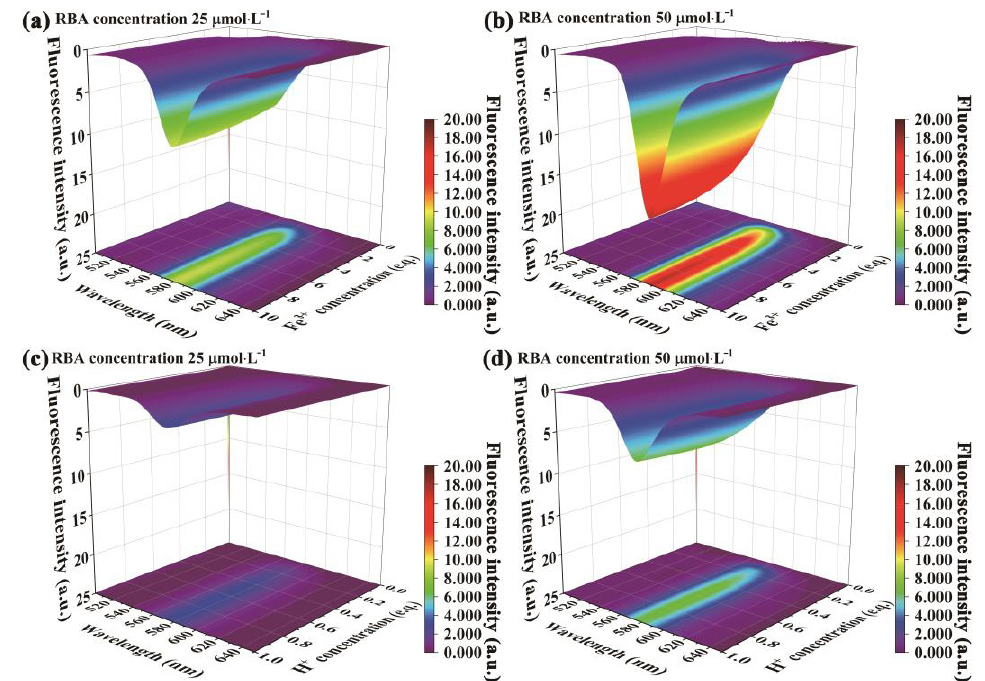
Nanomaterials 2021 , 11 , x FOR PEER REVIEW 12 of 18 Figure 7. Fluorescence emission behavior of RBA response to iron ion and proton, ( a ) RBA 25 µ mol · L − 1 , Fe 3 + , ( b ) RBA 50 µ mol · L − 1 , Fe 3 + , ( c ) RBA 25 µ mol · L − 1 , H + , ( d ) RBA 50 µ mol · L − 1 , H 2 + .